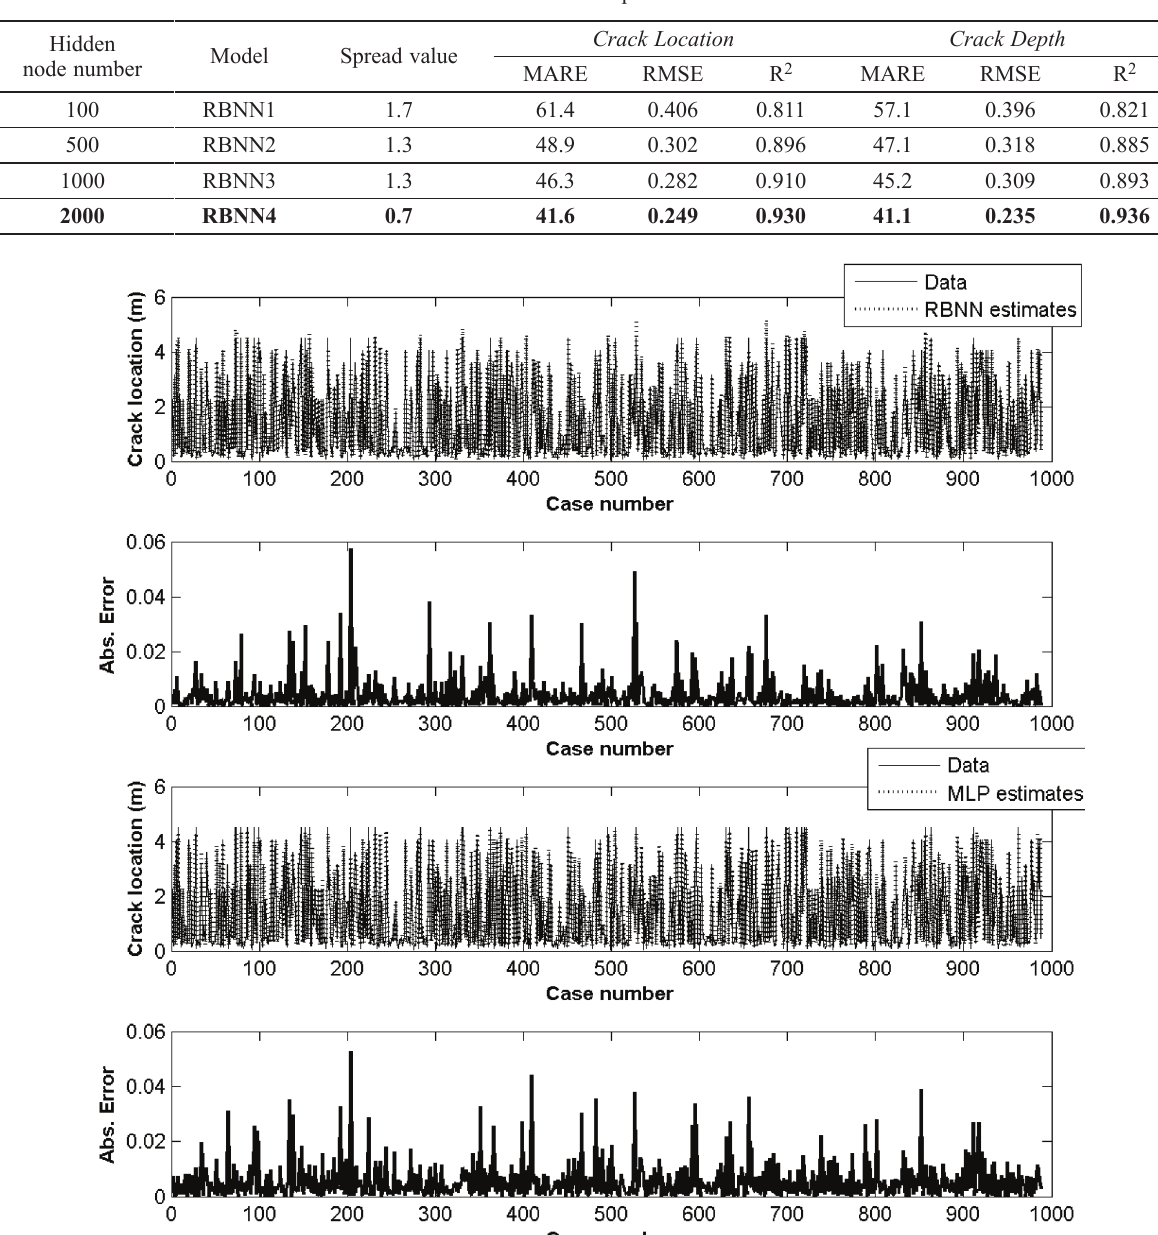
Fig. 6. The RBNN and MLP estimates of crack location and absolute errors in model